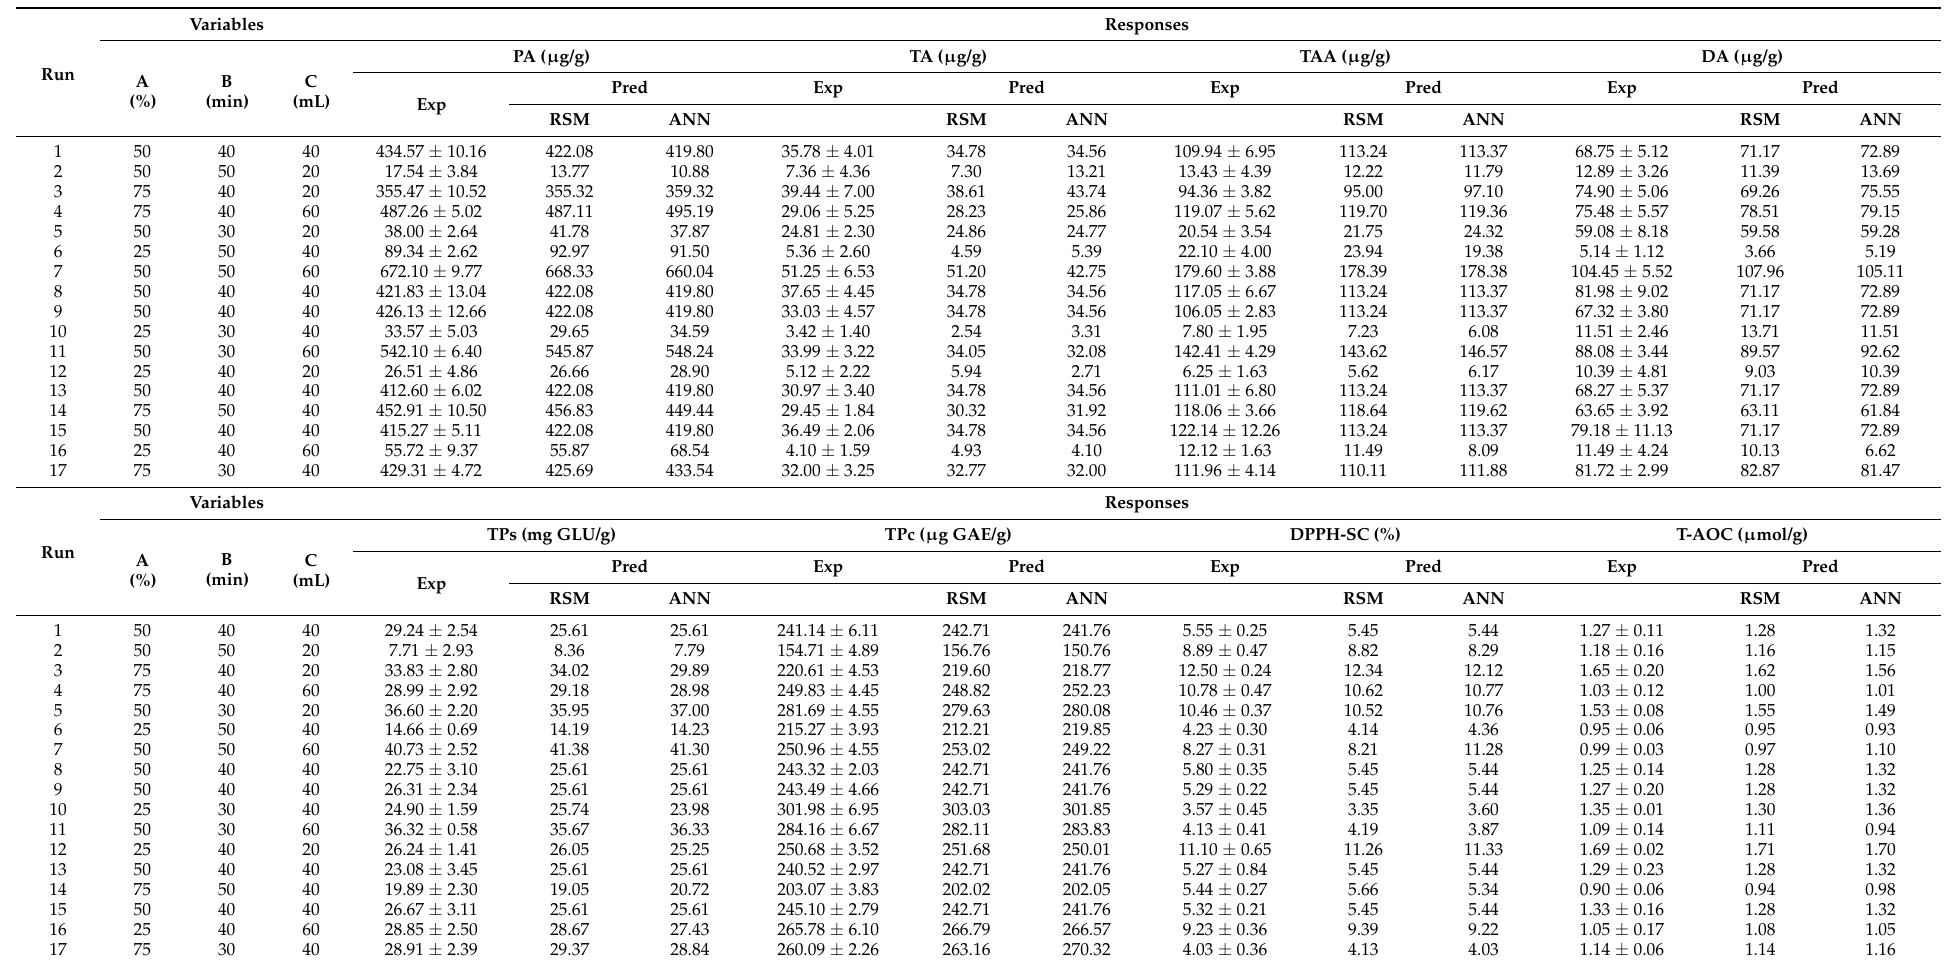
Table 1. Summary of design matrix for investigated responses (n =